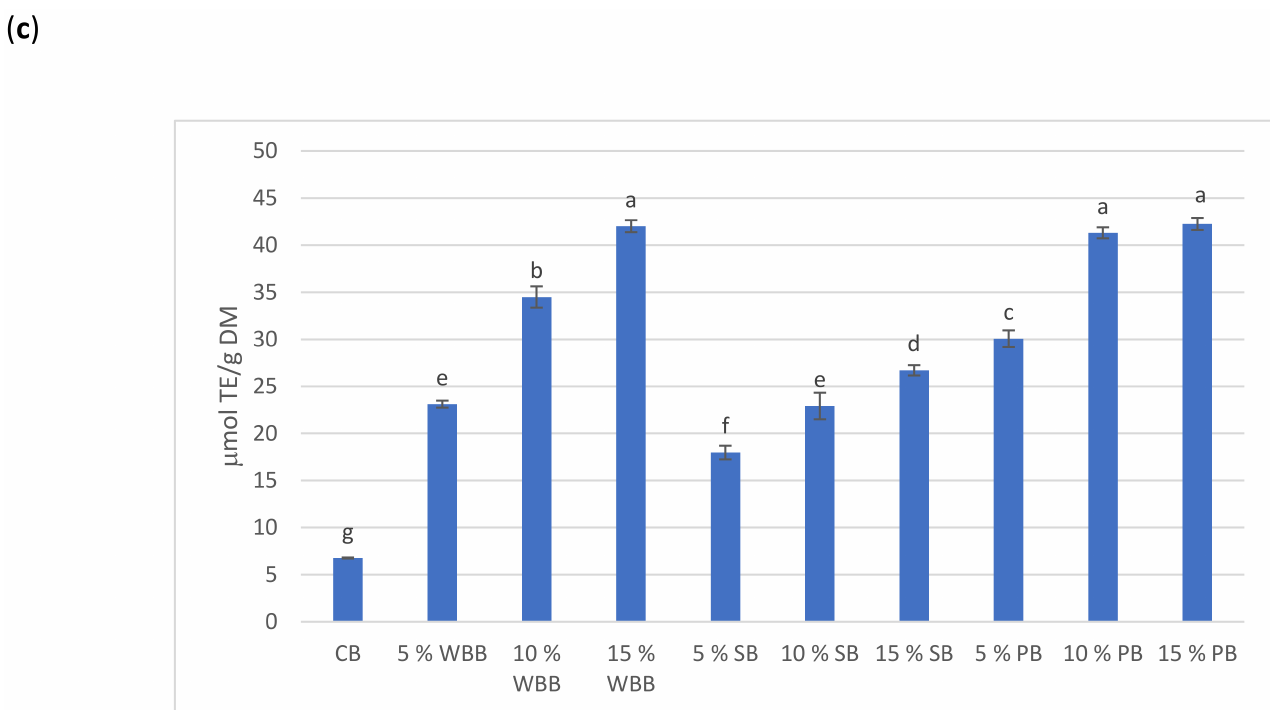
Figure 3. Values for total phenolic component (TPC) ( a ); antioxidant capacities: the DPPH. scavenging activities ( b ); and the ORAC assay results ( c ). Comparing the control bread (CB) to all mushroom powder enriched bread samples: white button mushroom bread (WBB); shiitake mushroom bread (SB) and porcini mushroom bread (PB). Error bars represent standard deviation of replicates. The same letter is not significantly different from each other ( p <